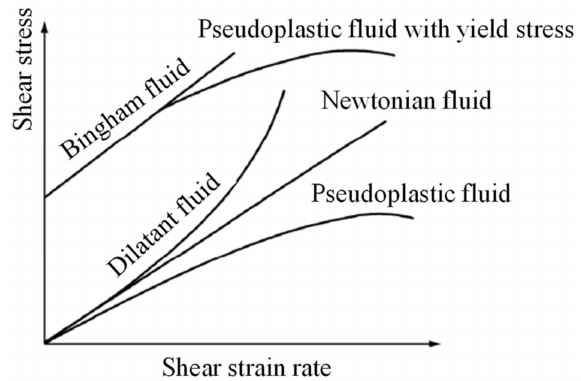
Figure 2. Schematic diagram for the relationship between the shear stress and shear strain rate of the paste.